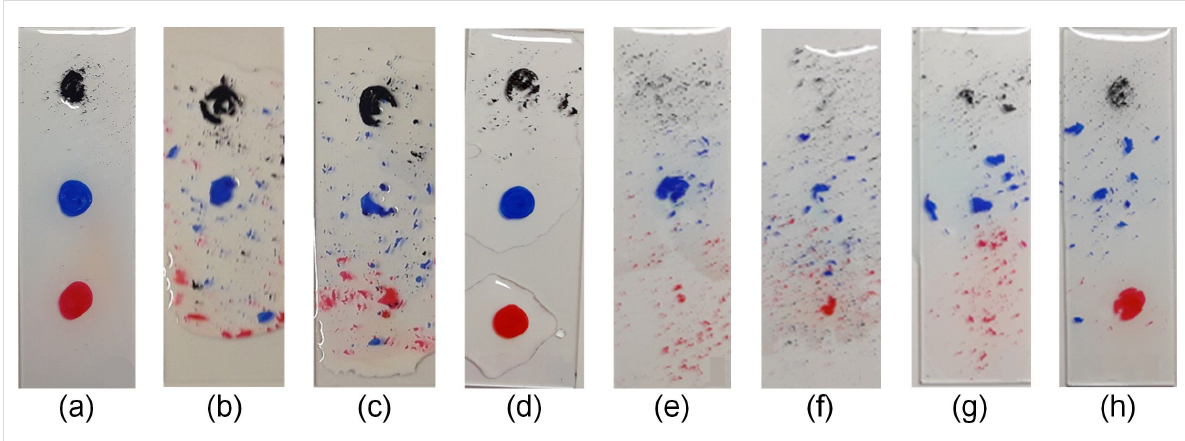
Figure 4: Anti-pollution characteristics of the coating films fabricated using various annealing treatment methods: (a) naturally dried; (b) annealed with RTA; (c) annealed with a furnace; (d) annealed once with a gas torch; (e) annealed two times with a gas torch; (f) annealed three times with a gas torch; (g) annealed four times with a gas torch; and (h) annealed five times with a gas torch.